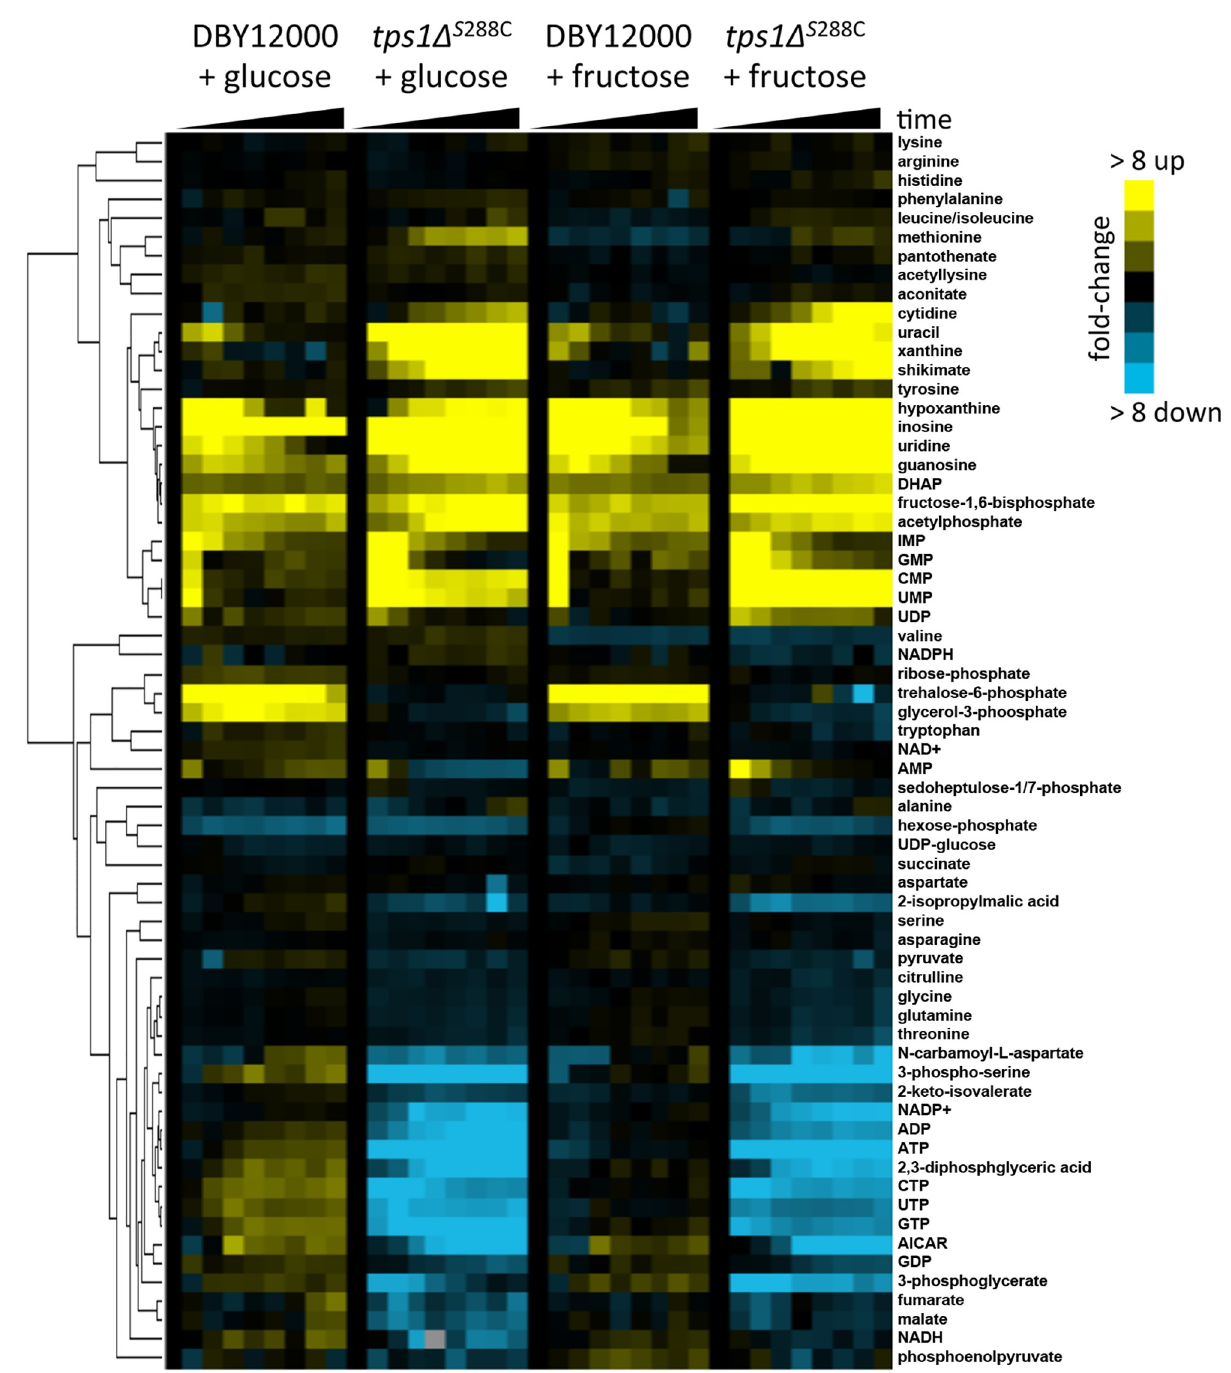
Fig 2. Glucose and fructose are metabolically similar in wild type and tps1 Δ . Indicated strains were grown to mid-log phase in YNB + 2% galactose before either glucose or fructose was added to 2% (as indicated in the figure). Cells were then collected at 0, 0.5, 1, 2.5, 5, 7.5, 10, 15, and 30 minutes (indicated as time on the graph) for metabolite extraction and analysis as described in Materials and Methods. Zero-normalized metabolite changes are shown after uncentered Pearson clustering, and a legend is included to indicate relationship between metabolite fold-changes and color changes. Strains used in this figure: DBY12000,